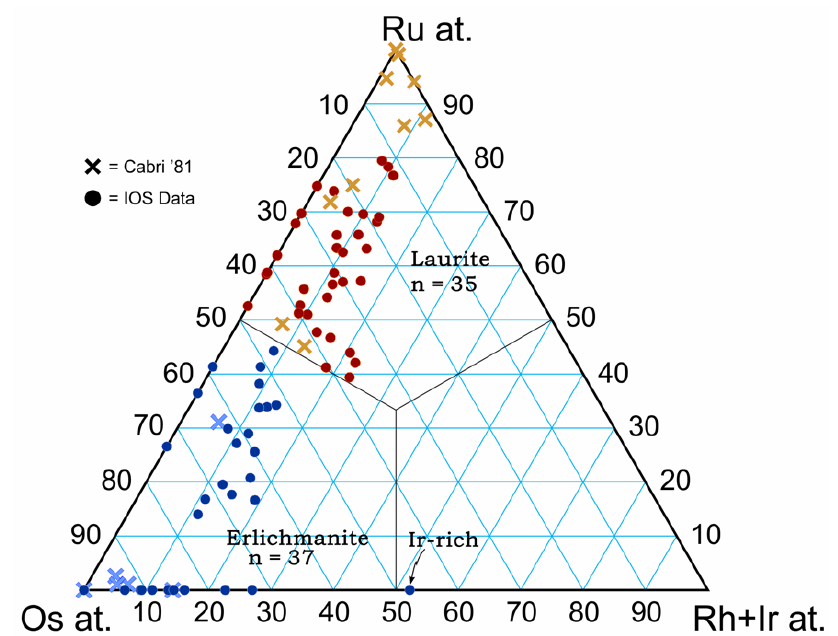
Figure 12. The Os-Ru-(Rh + Ir) diagram illustrates the compositional distribution of 72 PGM grains belonging to the laurite-erlichmanite series. The elemental values are presented in atomic proportions (at.). Data from Cabri [25] have been included to help establish the limits between laurite and erlichmanite